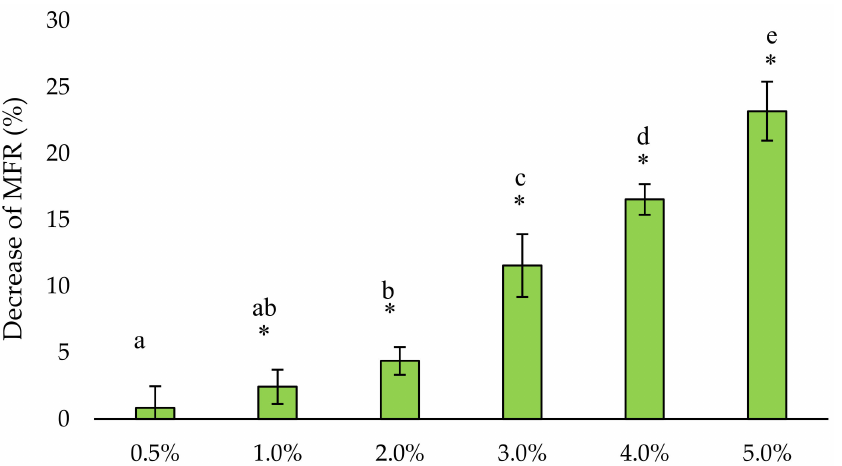
Figure 1. Mass melt flow rate (MFR) for samples containing 0.5% to 5% of the biocide (differences from control—samples without biocide). Statistically significant differences from the controls are marked with an asterisk. Statistically significant differences between the variants are marked with separate